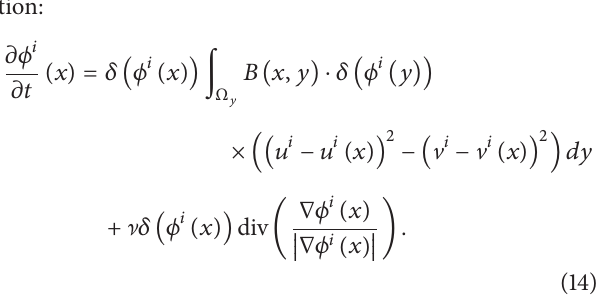
to approximate the original noisy image with a fitting image which is obtained through neighborhood average filter.